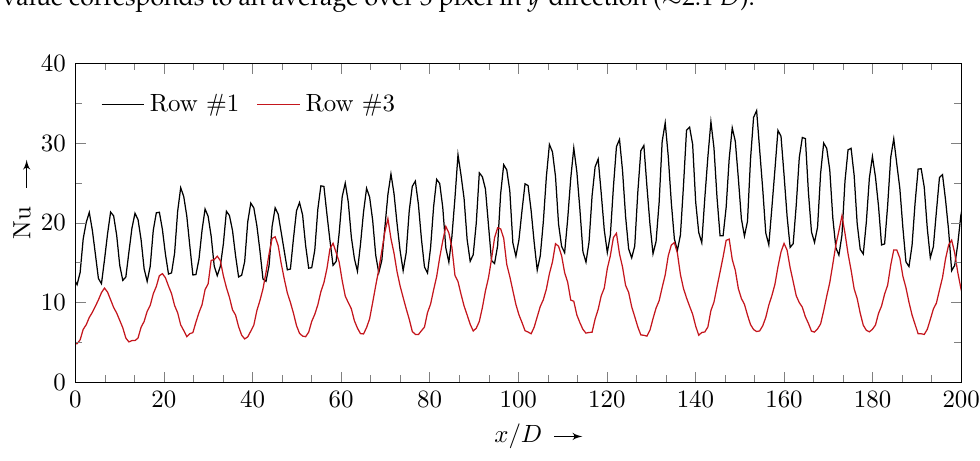
Figure 8. Nusselt number along the centerline of row #1 and #3 for Re =